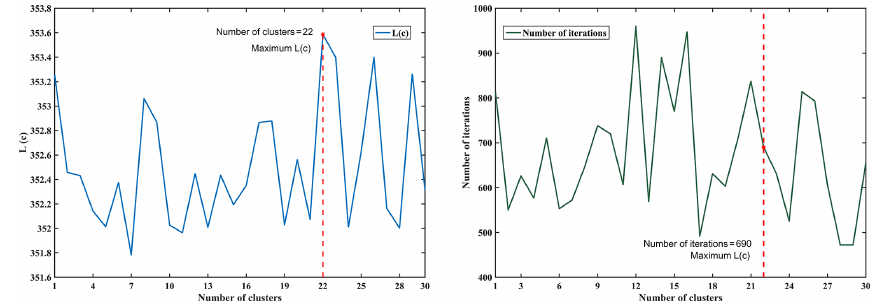
Figure E1. Optimum number of clusters determined by the maximum L ( c ) with the iterative process.